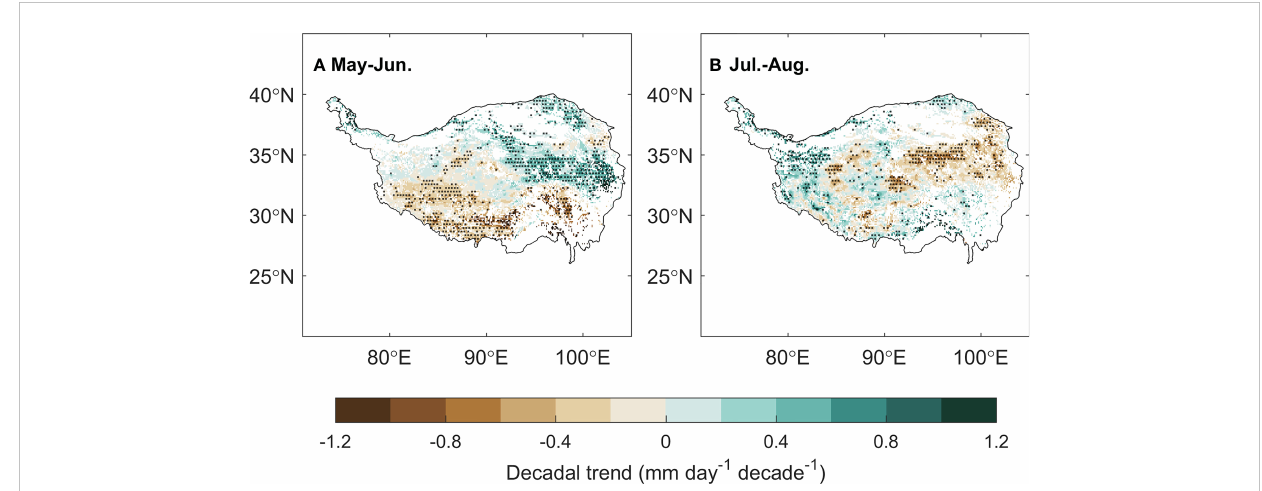
FIGURE 7 The spatial distribution of the decadal trend of the precipitation in May – June (A) and July – August (B) .